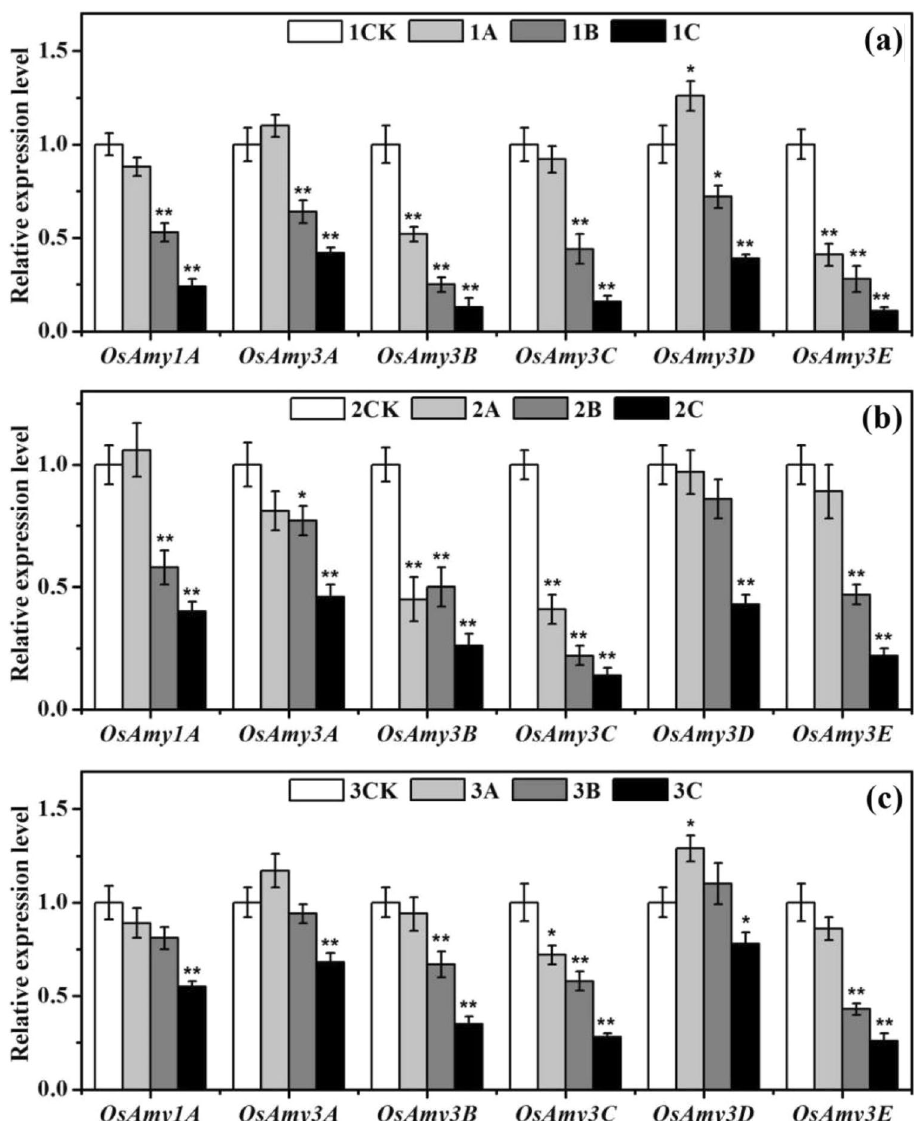
Figure 5. qPCR analysis of the key α-amylase genes ( OsAmy1A , OsAmy3A , OsAmy3B , OsAmy3C , OsAmy3D , OsAmy3E ) in the nonirradiated and irradiated groups whose plants were subjected to different doses of ionizing radiation. The results are reported as the relative expression of each gene transcript with respect to an internal standard. The relative value of the expression of each gene in the nonirradiated sample was set to 1. The vertical bars represent the means ± SEs of three independent biological replicates ( n = 3). * and ** denote significance at the P < 0.05 and P < 0.01 levels, respectively, compared with the control group; ( a ), ( b ), and ( c ) represent XD10- 01 ( ♀ ), BX10 ( ♂ ), and XJ (04)-08,